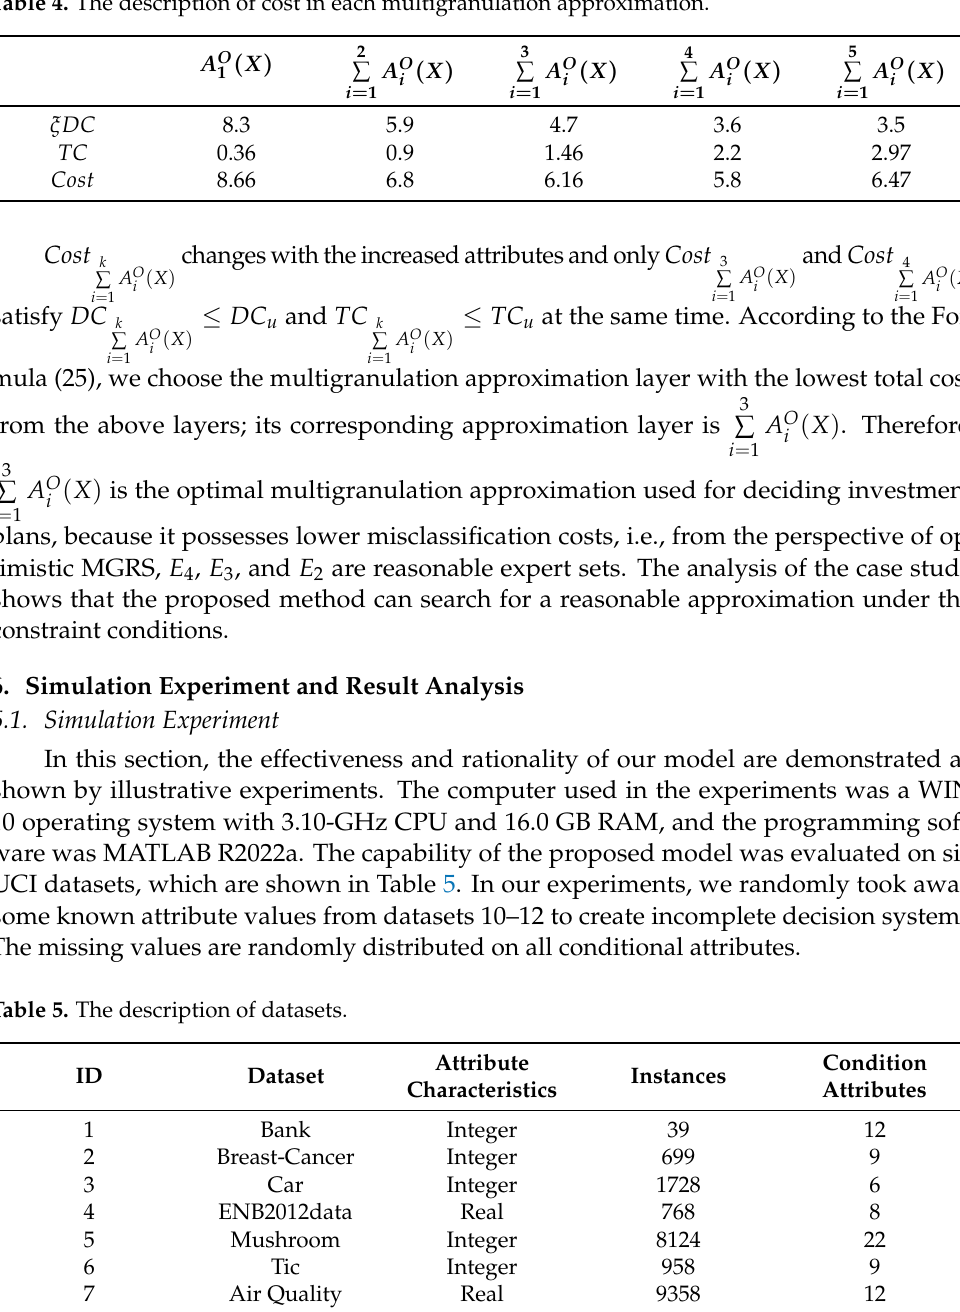
Table 4. The description of cost in each multigranulation approximation.